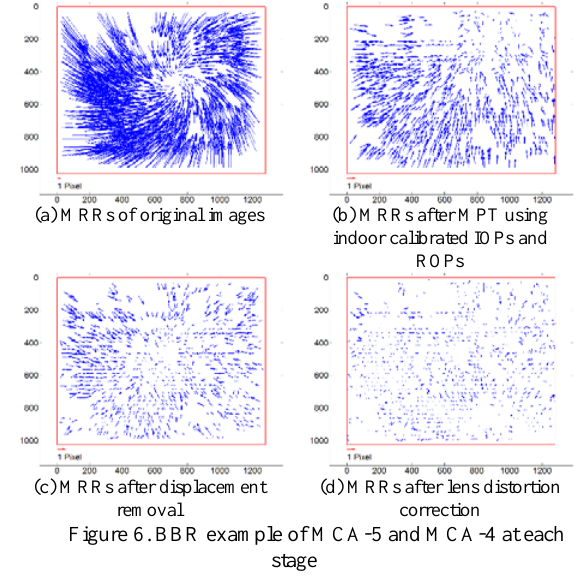
Figure 6. BBR example of MCA-5 and MCA-4 at each stage Table 3. Systematic corrections for BBR at each stage Ref. Figure